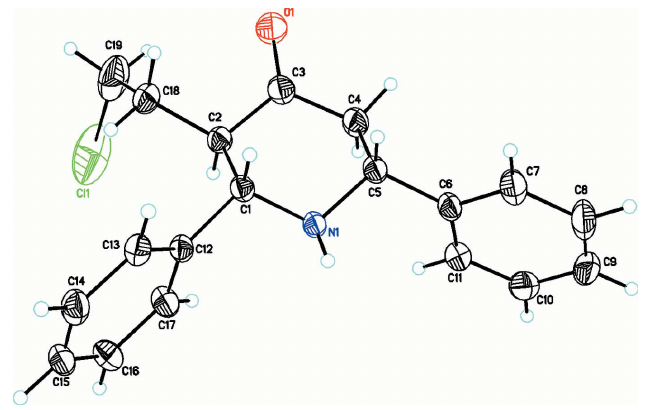
Figure 1 A view of the molecular structure of (I), showing displacement ellipsoids drawn at the 30% probability level.